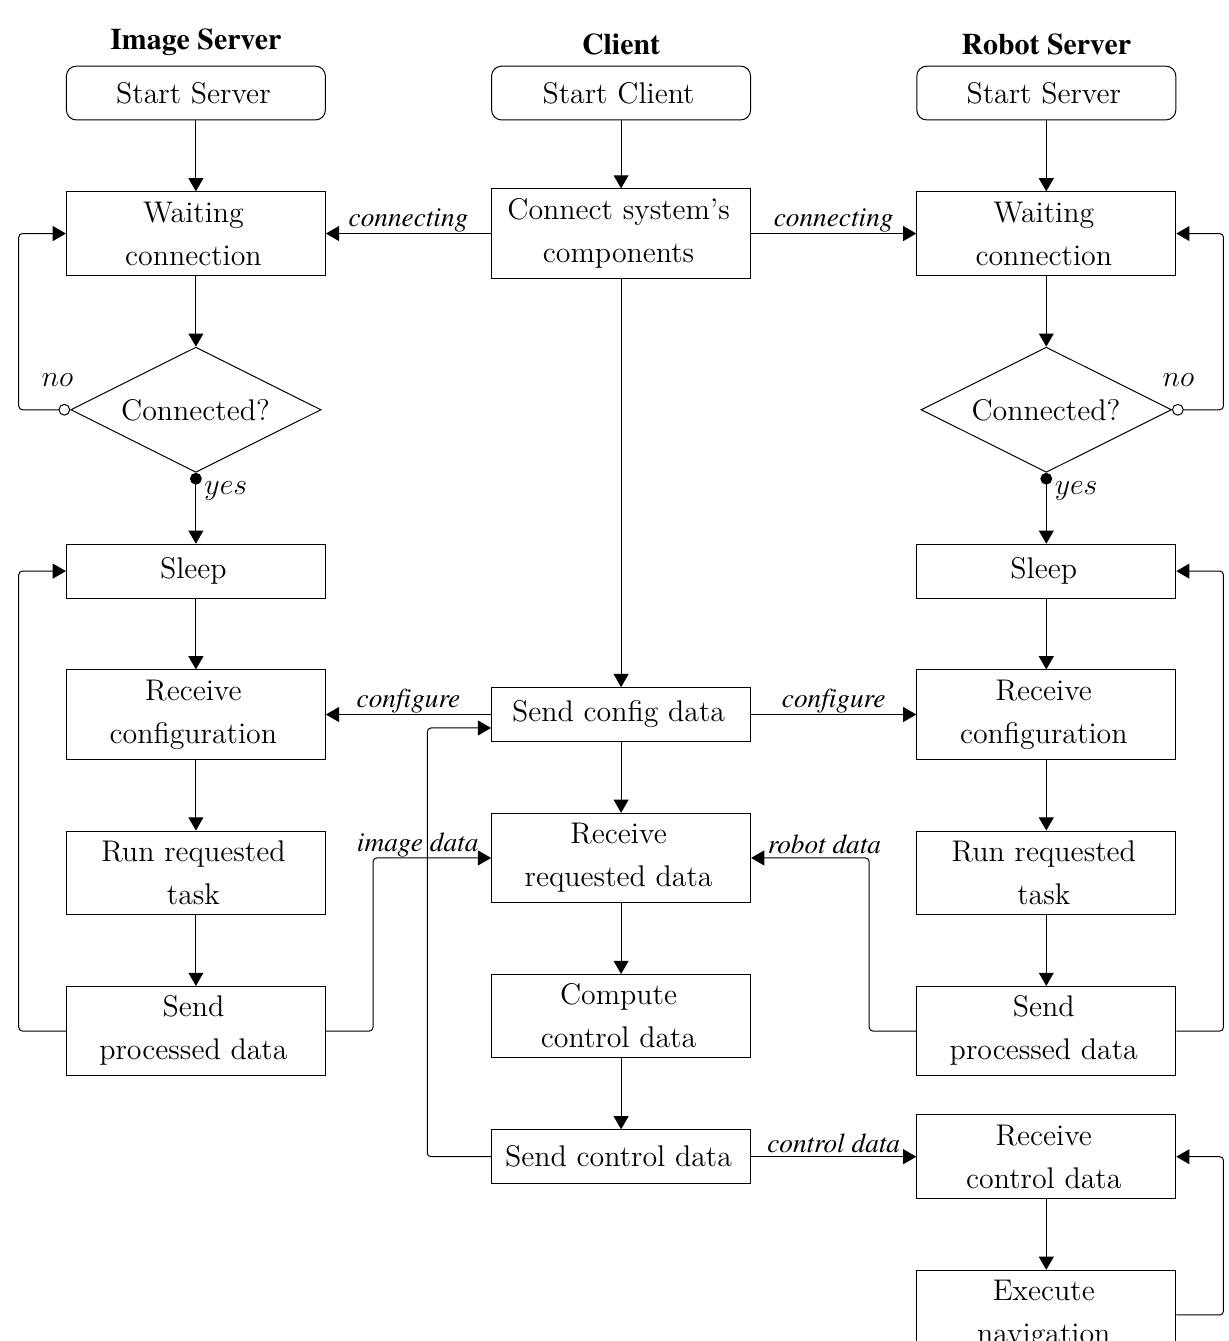
Figure 4. Flowchart of the basic structure of the intelligent